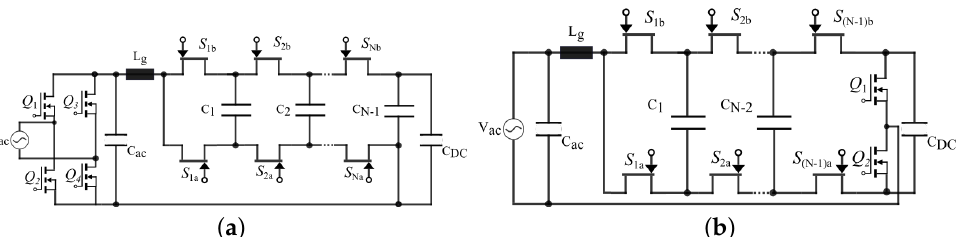
Figure 17. Generalized structure of single-phase N-level FCML totem-pole GaN PFC ( a ) with H- bridge unfolder/folder and ( b ) with half-bridge